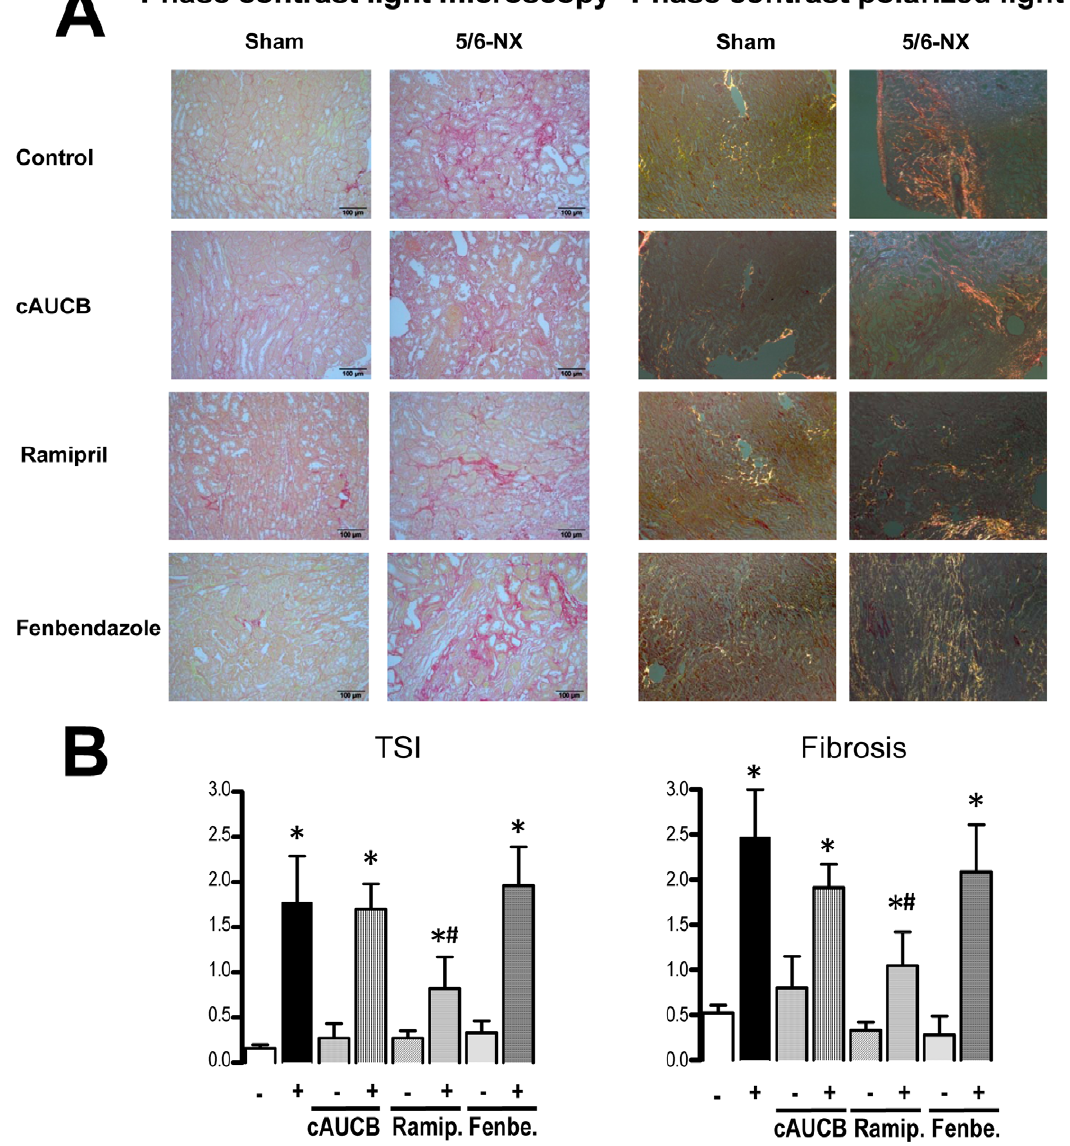
Figure 3. Histological tubulointerstitial changes. Representative kidney sections (magnification 6 100) stained by Sirius Red in phase contrast light microscopy and polarized light microscopy scoring tubulointerstitial damage index (TSI) and interstitial fibrosis after 8 weeks of treatment. Effects of placebo, sEH-inhibition by cAUCB, ACE-inhibition by ramipril (Ramip.) and CYP-inhibition by fenbendazole (Fenbe.) are shown on sham operated ( 2 ) and 5-6-Nx ( + ) animals. * p , 0,05 vs. sham, # p , 0,05 vs. placebo (n=5–8/group). The scale bar denotes 100 m meter.